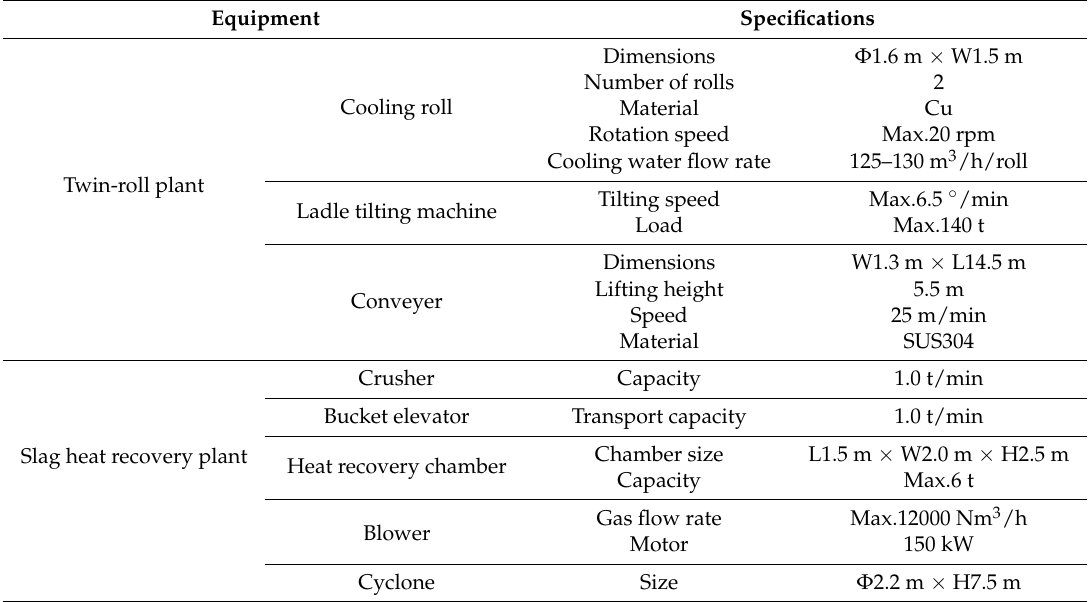
Figure 9. Exterior of pilot plants: ( a ) Twin-roll plant, ( b ) Slag heat recovery plant. Table 3. Specifications of slag heat recovery pilot plant.